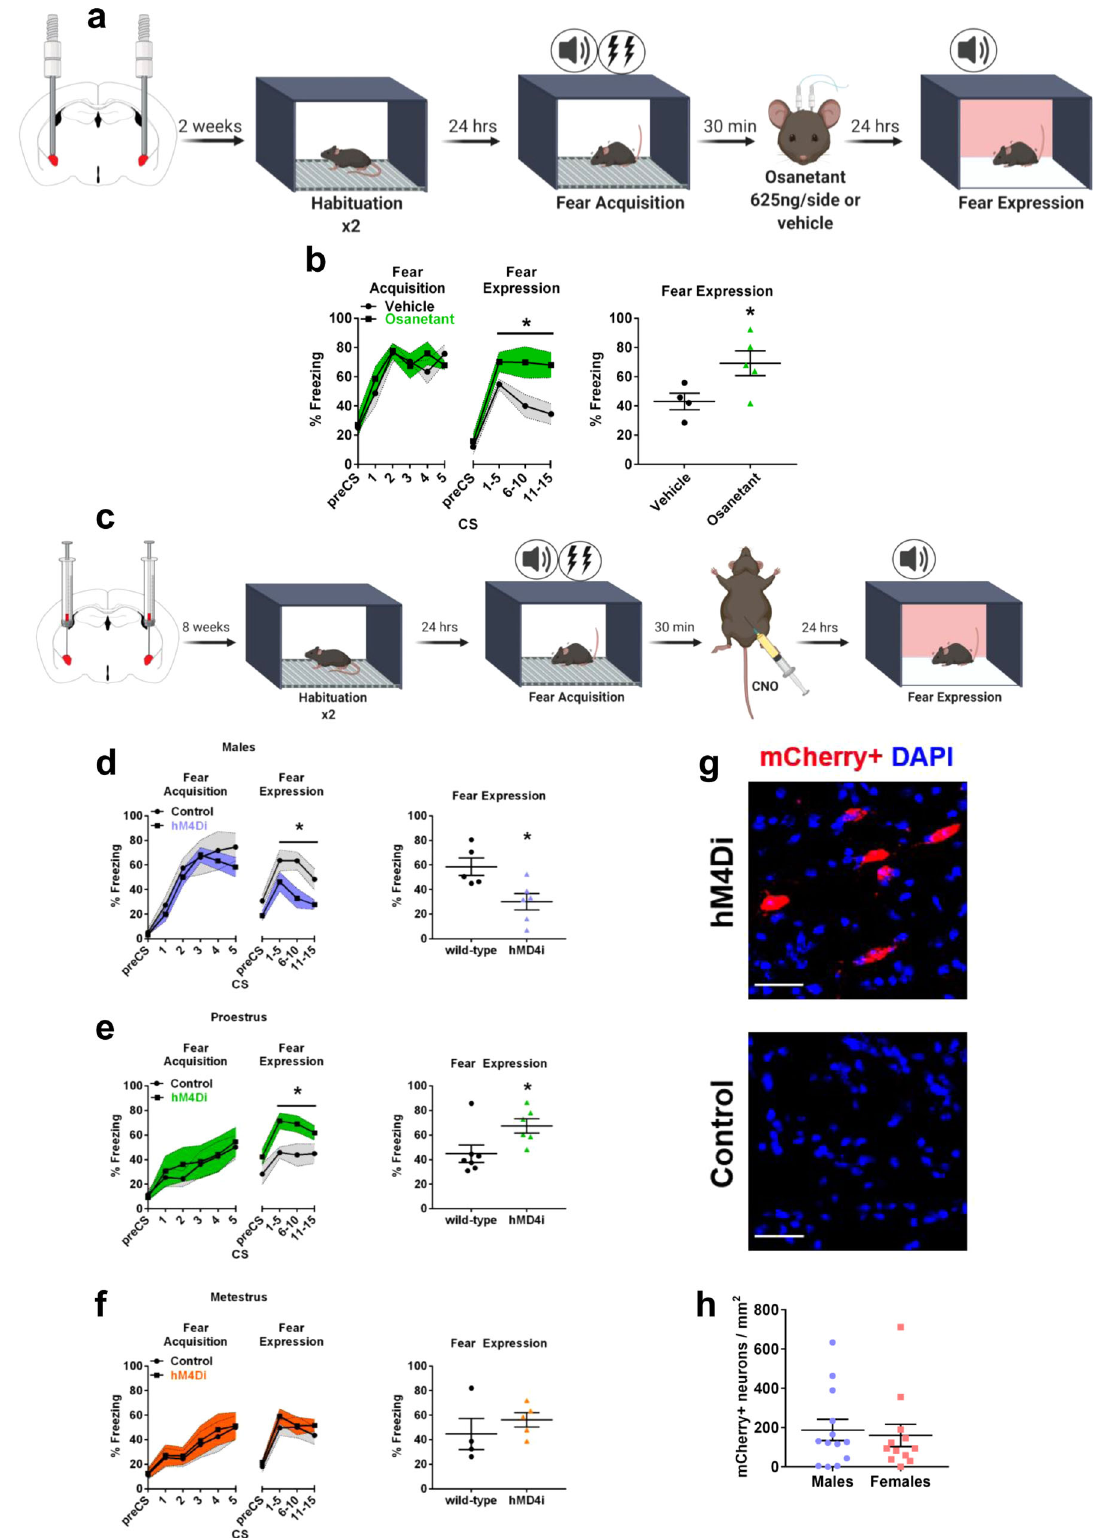
the FA and drug administration day. Females that expressed mCherry in the CeA, and received FA and CNO in proestrus presented increased memory consolidation (Fig. 4e, F (1,11) = 5,897, p = 0.034), while this effect was absent during metestrus (Fig. 4f, F (1,7) = 0.784, p = 0.405), all compared to wild-type controls also injected with the AAV without the